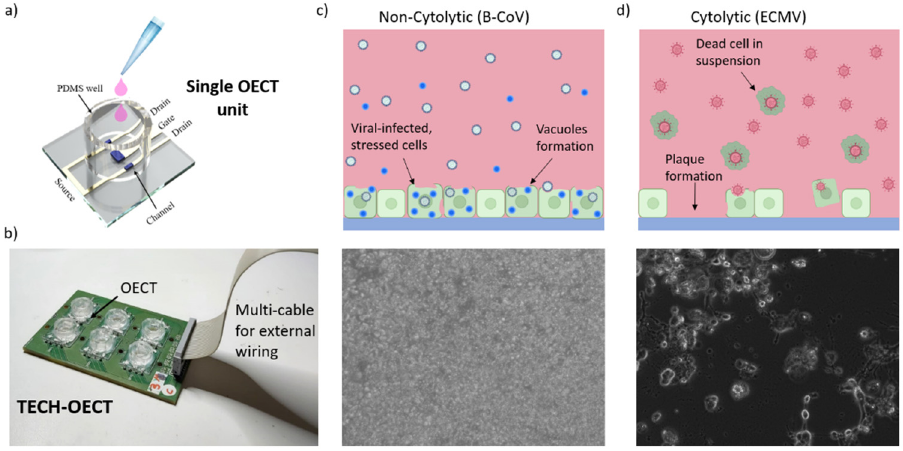
Figure 1. ( a ) An OECT render schematic. ( b ) The TECH-OECT system used for the measurements inside the incubator. The schematic non-cytolytic ( c ) and cytolytic ( d ) viral action (top) and micrograph (bottom) are on the cell lines .